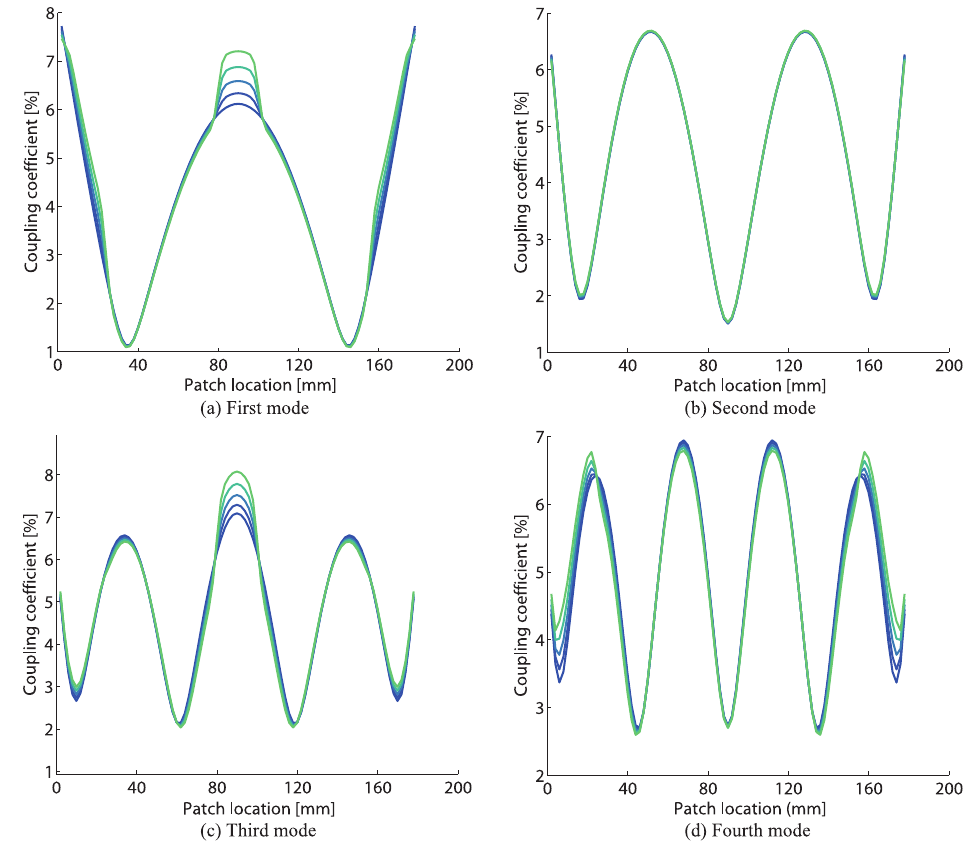
Fig. 4. Electromechanical coupling coefficient for one piezoelectric patch on the beam from x as = 0 mm to x as = 180 mm and for a crack depth from μ = 0 to μ = 1 / 4 ( (cid:2) : μ = 0 , (cid:2) : μ = 1 / 16 , (cid:2) : μ = 1 / 8 , (cid:2) : μ = 3 / 16 , (cid:2) : μ = 1 / 4